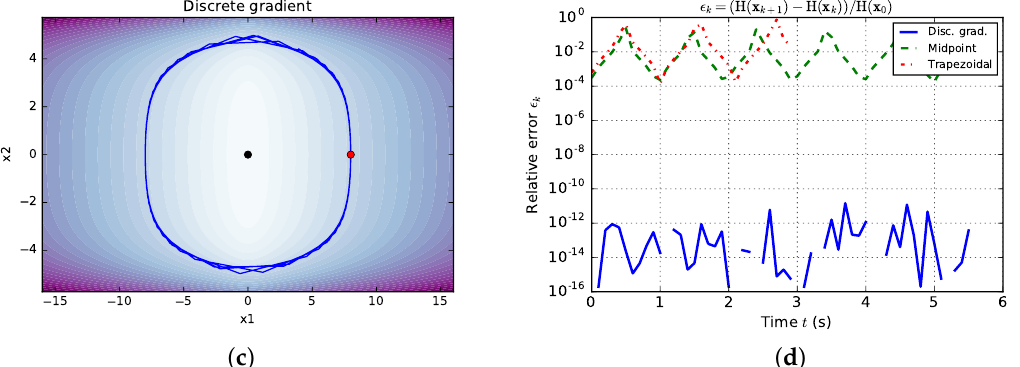
Figure 4. Simulation results and comparison of the methods in Table 3, for a nonlinear conservative = J x ( x ) with ( x ) given in (30): ( a ) Trapezoidal rule; ( b ) Midpoint rule; ( c ) PHS system d x d t · ∇H H combined with discrete gradient; ( d ) Relative error on energy balance.The comparison measure is the relative error on the power balance defined by (cid:101) ( k ) =